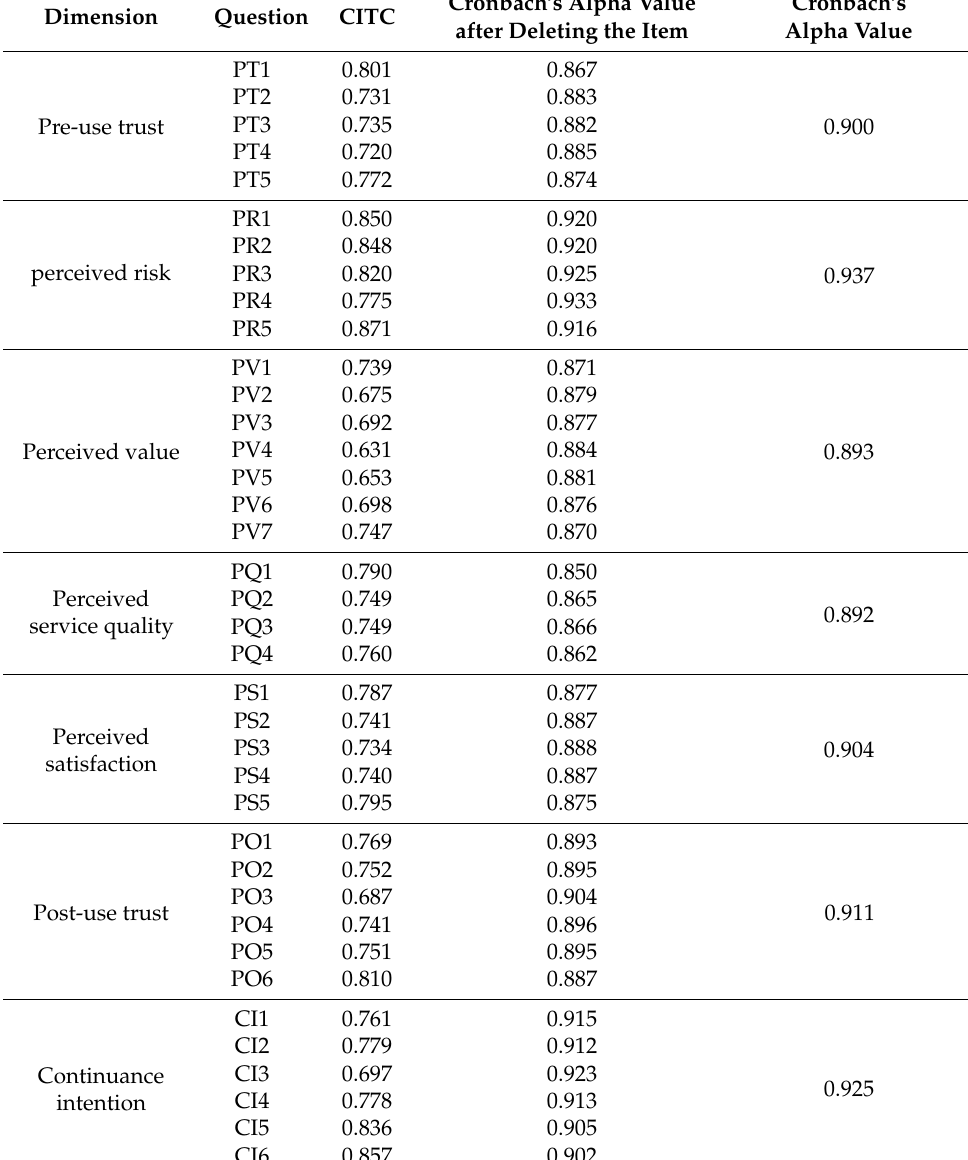
Table 2. Reliability and items analysis of the dimension